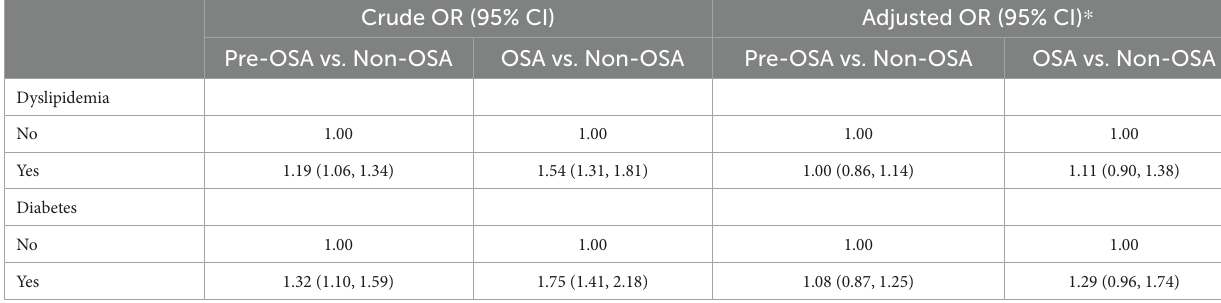
* Adjustment for age, gender, marital status, educational status, body mass index, leisure-time physical activity, waist-hip ratio, PM 2.5 concentration, work intensity, active smoking, passive smoke, alcohol drinking, fruit intake, fresh vegetable intake, hypertension, dyslipidemia, diabetes, chronic obstructive pulmonary disease, and cardiovascular diseases. OSA, obstructive sleep